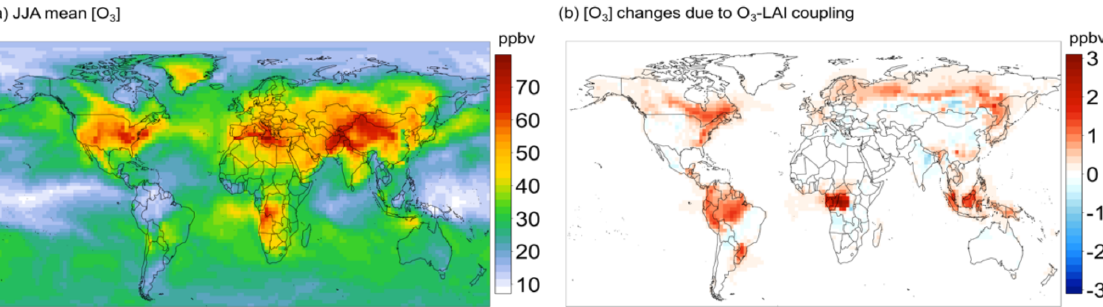
Figure 8. (a) Surface ozone concentration with ozone-affected leaf area index (LAI) in summer (JJA mean) from the Affected_LAI case for asynchronous ozone–LAI coupling, and (b) differences in JJA ozone concentration between the Affected_LAI and Intact_LAI case (i.e., Affected_LAI – Intact_LAI).